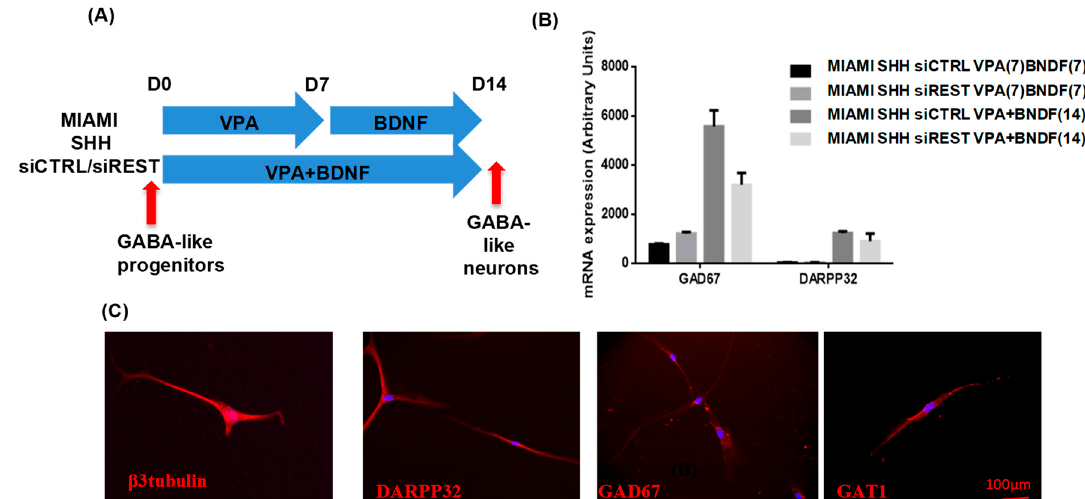
Figure 4. Differentiation and Characterization of GABA-like neurons. ( A ) Schematic procedure of GABAergic differentiation. For both protocols, the concentration of VPA was 10 mM and 30 ng/mL of BDNF). ( B ) The characterization of the differentiation was realized by RT-qPCR. The expression of genes DARPP32 and GAD67 was quantified at the end of the differentiation ( N = 2, n = 1). ( C ) In vitro immunofluorescence against β 3-tubulin, DARPP32, GAD67, GAT1 on GABA-like neurons was performed.